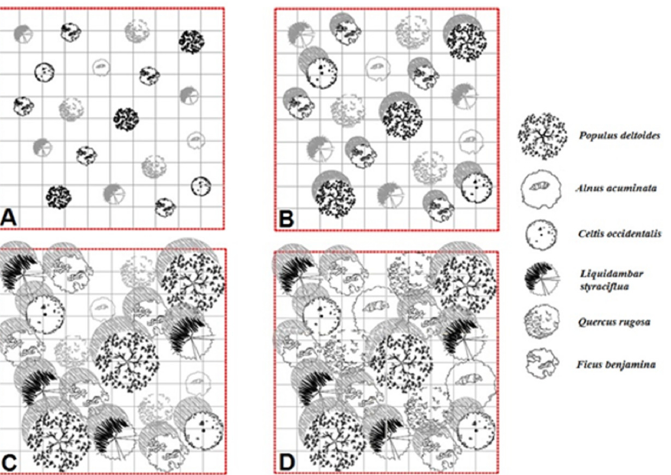
Figure 2. Proposed urban park design conformed by a tree community module and its enlargement over time, from the initial planting (( A ), 2 years) to full growth (( D ), ≥ 20 years), growing differentially due to different species growth rates. Fast-growing trees exceed the other trees in size generating shade zones (( B ), 15 years), while moderate-growth trees surpass slow-growing trees in size in the medium-term, ameliorating the environment by producing more shade zones whereas fast-growing trees have full growth (( C ), ≥ 15